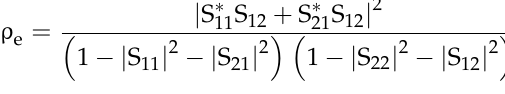
Figure 6. Simulated frequency shift capability with different lengths L a and L b from 1–5 mm and 9–13 mm, respectively.